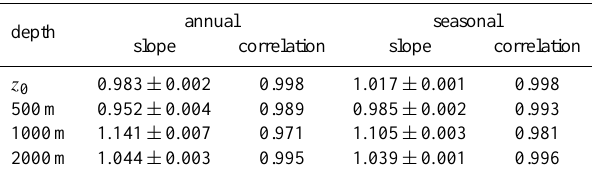
Table 1. Parameters from type II linear regressions of POC flux estimates from exponential model (Eq. 1) against POC flux from CCSM–BEC at different depths. The regression slopes are shown with their 95% confidence interval. The linear regressions were computed using annual and seasonal means of POC flux from CCSM–BEC and their corresponding exponential model fit (annual and seasonal, see Sect.